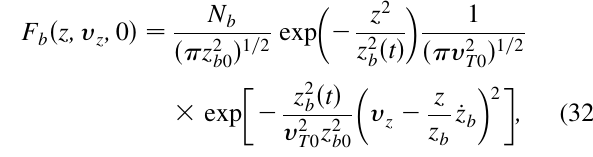
FIG. 1. For negative initial velocity tilt (cid:1) _ z (cid:1) t (cid:2) [Eq. (24)] compresses to a minimum size bunch length z b z at time t (cid:4) t [Eqs. (26) and bf f